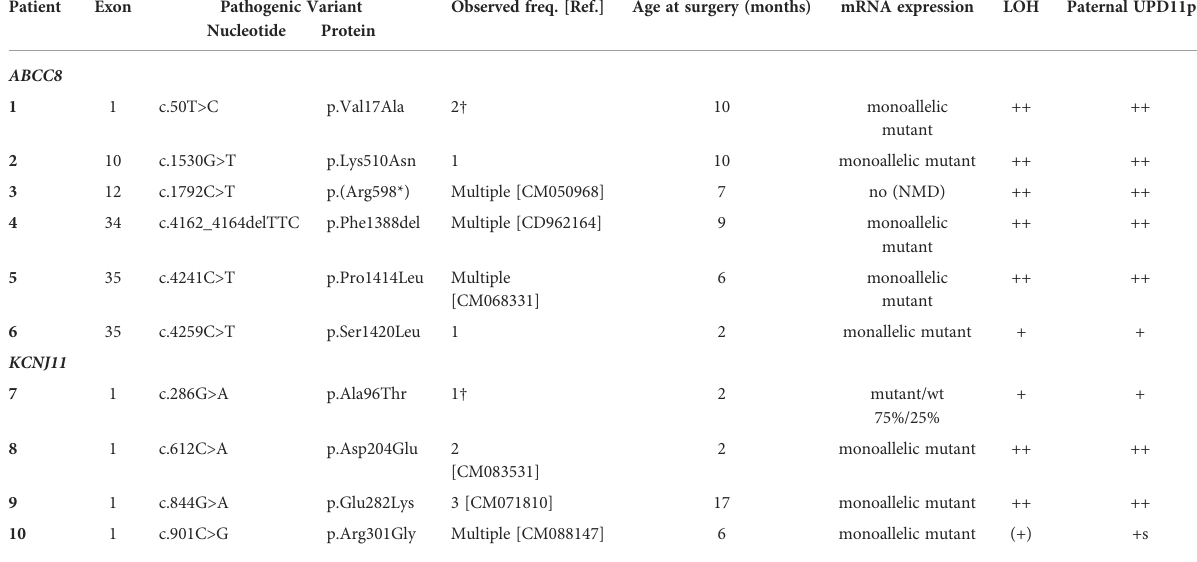
TABLE 1 Genetic and expression analysis of pancreatic lesions from focal CHI. Patient Exon Pathogenic Variant Nucleotide